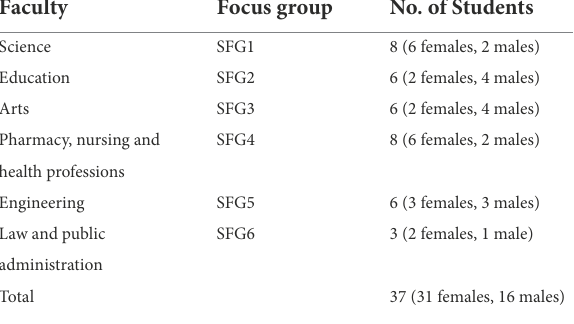
TABLE 2 Distribution of students on the focus group